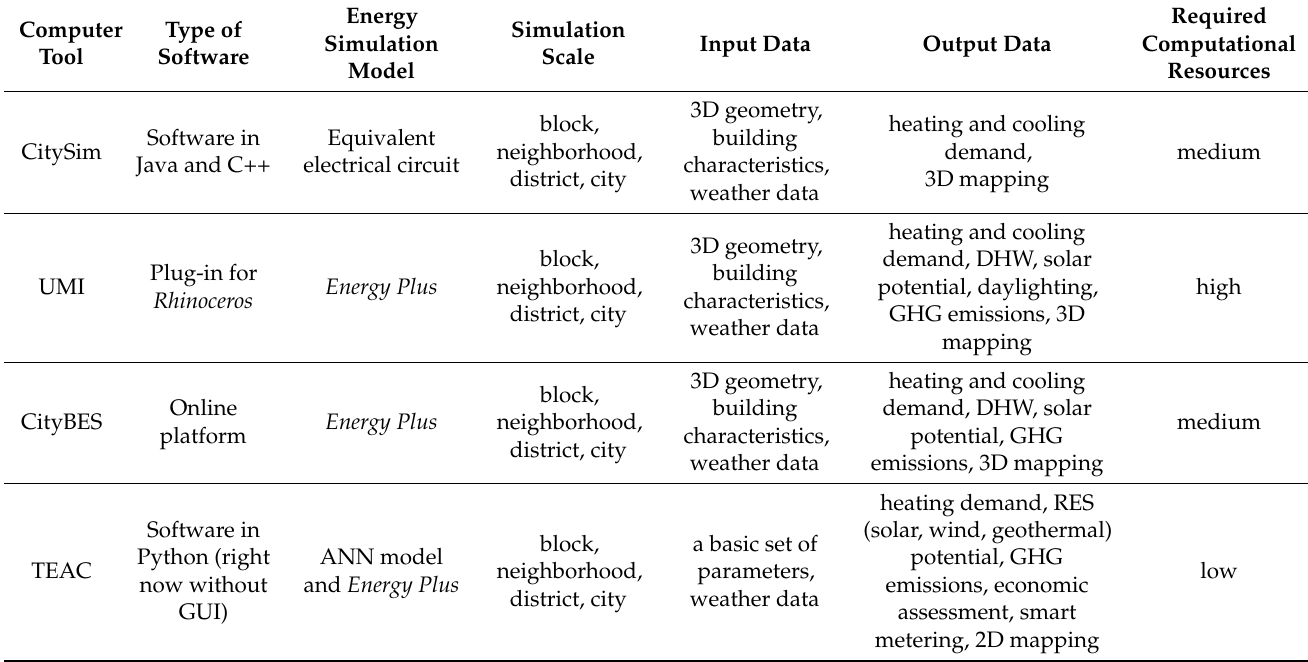
Table 1. Summary of the considered UBEM